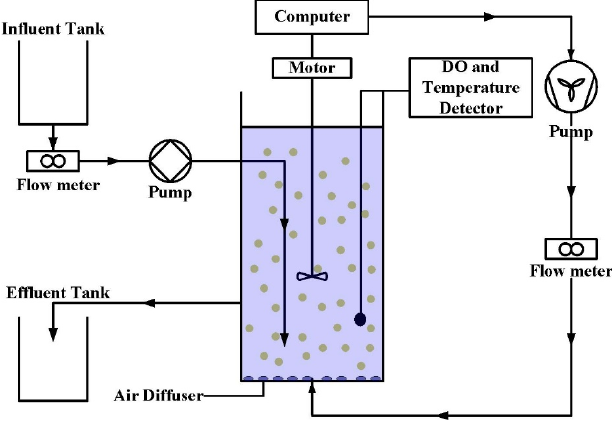
Figure 1. Configuration of a sequencing batch reactor (SBR) reactor. DO—dissolved oxygen.